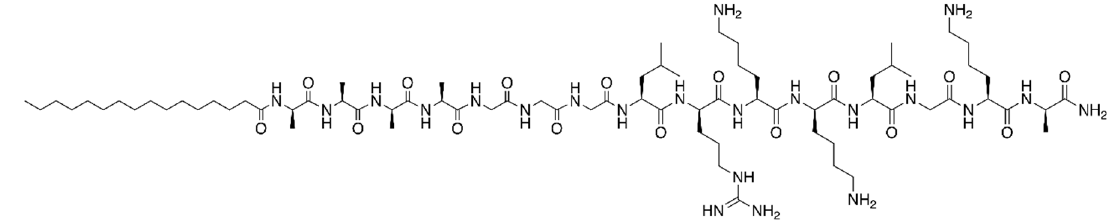
Figure 3. Structure of the peptide amphiphile PA, developed by Ranjagam and co-workers [75].